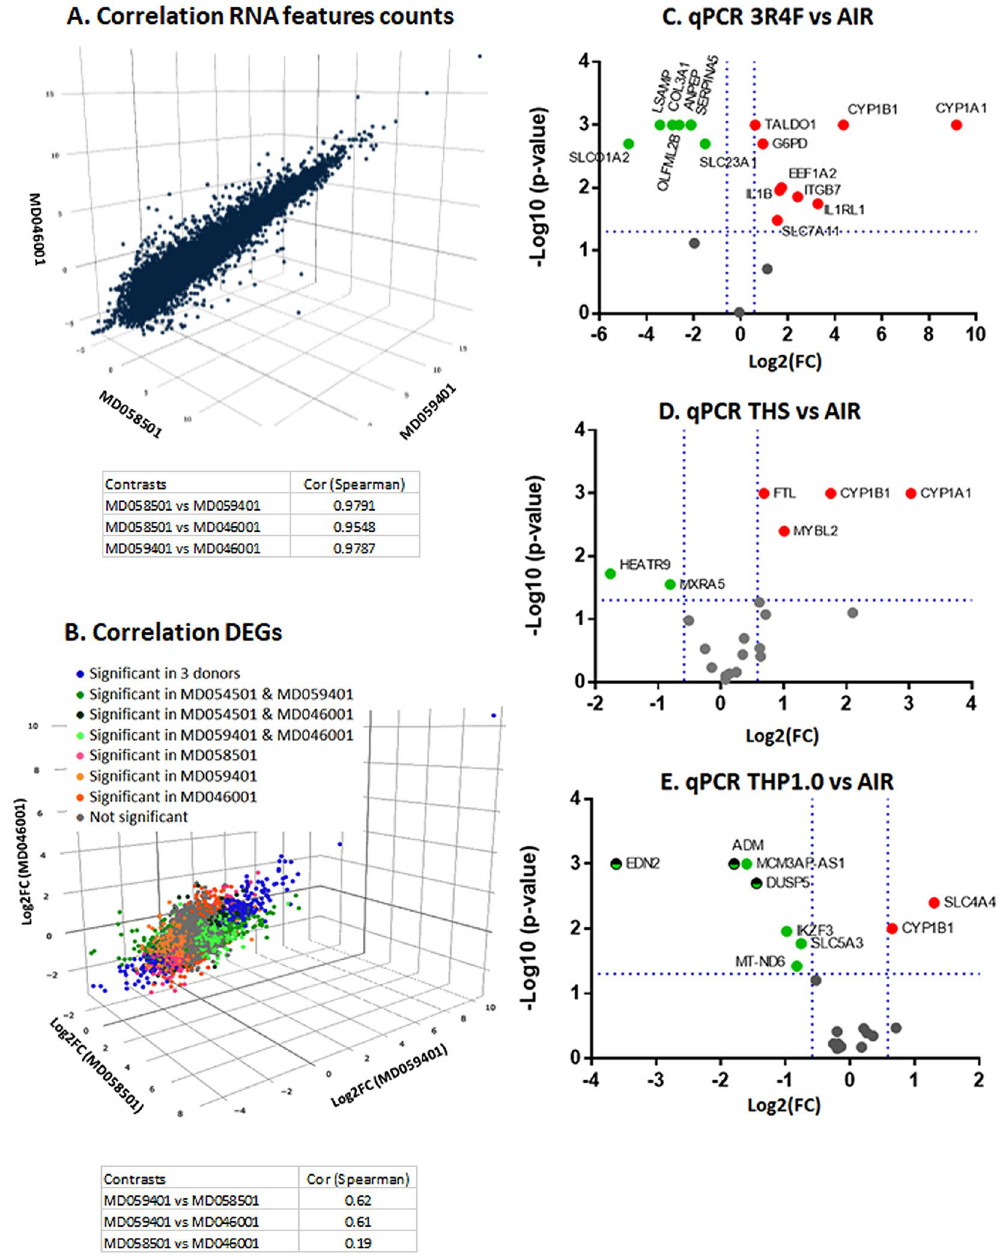
Figure 7. Gene expression validation in multiple donors. ( A ). Correlation plot of the normalized RNA-counts in the air controls from MucilAir ™ donor MD059401 used in this study and MucilAir ™ donor MD058501 used in a previous study 13 and donor MD046001 from an unpublished study (raw sequence files provided). ( B ). Correlation plot of the Log2(FC) of the expressed genes found in common in the 3 MucilAir ™ at 24 hrs post-exposure to cigarette smoke. Cells from MD58501 and MD059401 were exposed to smoke from 3R4F for an hour, cells from MD046001 were exposed to 1R6F cigarette smoke for an hour. The blue label indicates DEG (differentially expressed genes pFDR < 0.05) significant in the 3 donors, green labels have been used for DEGs significant in two donors, orange/pink labels have been used for DEGs significant in one donor, and the grey label have been used for gene not differentially expressed. Volcano plots for the qPCR validations of sets of 20 genes selected from the RNA-seq data performed with three donors showing 3R4F vs air ( C ) THS vs air ( D ) and THP1.0 vs air ( E ). The doted blue lines show the − log10(p-value = 0.05) and log2(FC = ± 1.5) thresholds. Genes that were significant at these thresholds are annotated on the plots and colored in red for up-regulation and green for